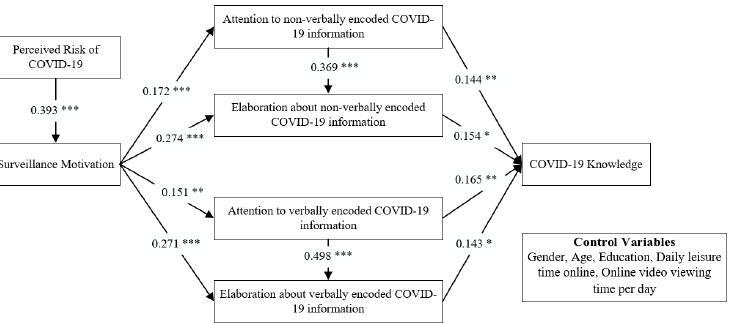
Figure 3. Knowledge learning path model of COVID-19 video viewers. * p < 0.05, ** p < 0.01, *** p <